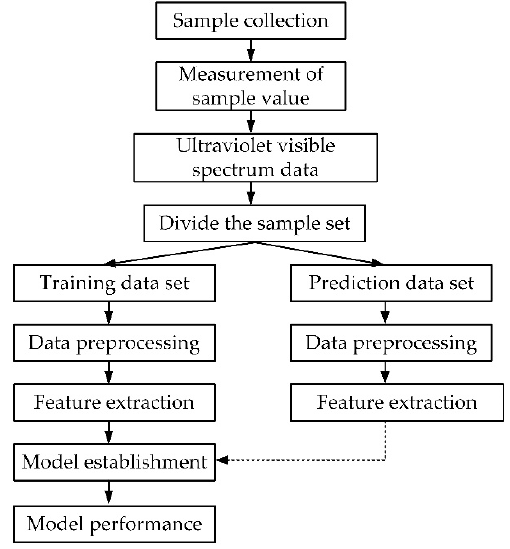
Figure 4. The steps of establishing a prediction model of water quality.